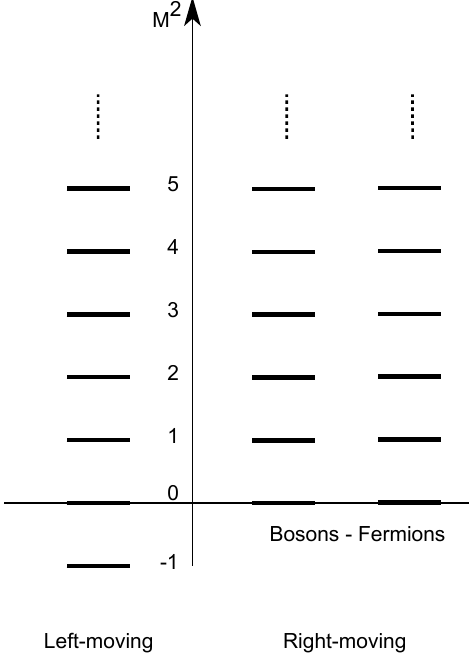
Figure 2 . Shown are left- and right-moving spectra relevant for the elliptic genus of a perturbative heterotic string with (1 ; 0) supersymmetry in d = 6. In the right-moving periodic Ramond sector, the massive towers cancel due to world-sheet supersymmetry, but they can also be mapped into towers that cancel between bosons and fermions due to space-time supersymmetry. In this way we see that the left-moving, U(1)-charged excitations can be level-matched to excitations in the vacuum modules of the right-moving sector, to form physical supermultiplets with (cid:12)xed